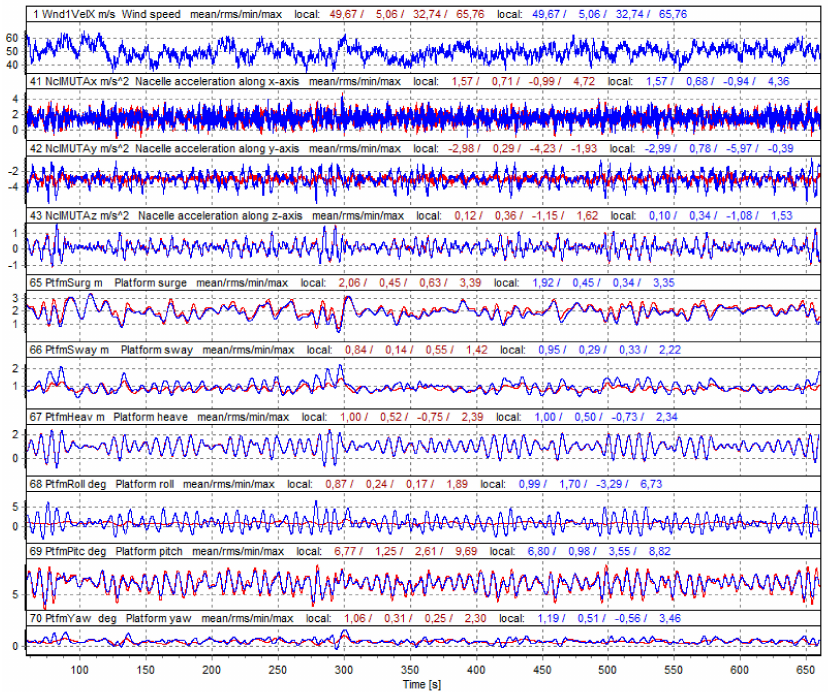
Figure 12. Time history of platform motions and nacelle acceleration from simulation with wind–wave misalignment (shown in red) and simulation without wind–wave misalignment (shown in blue).